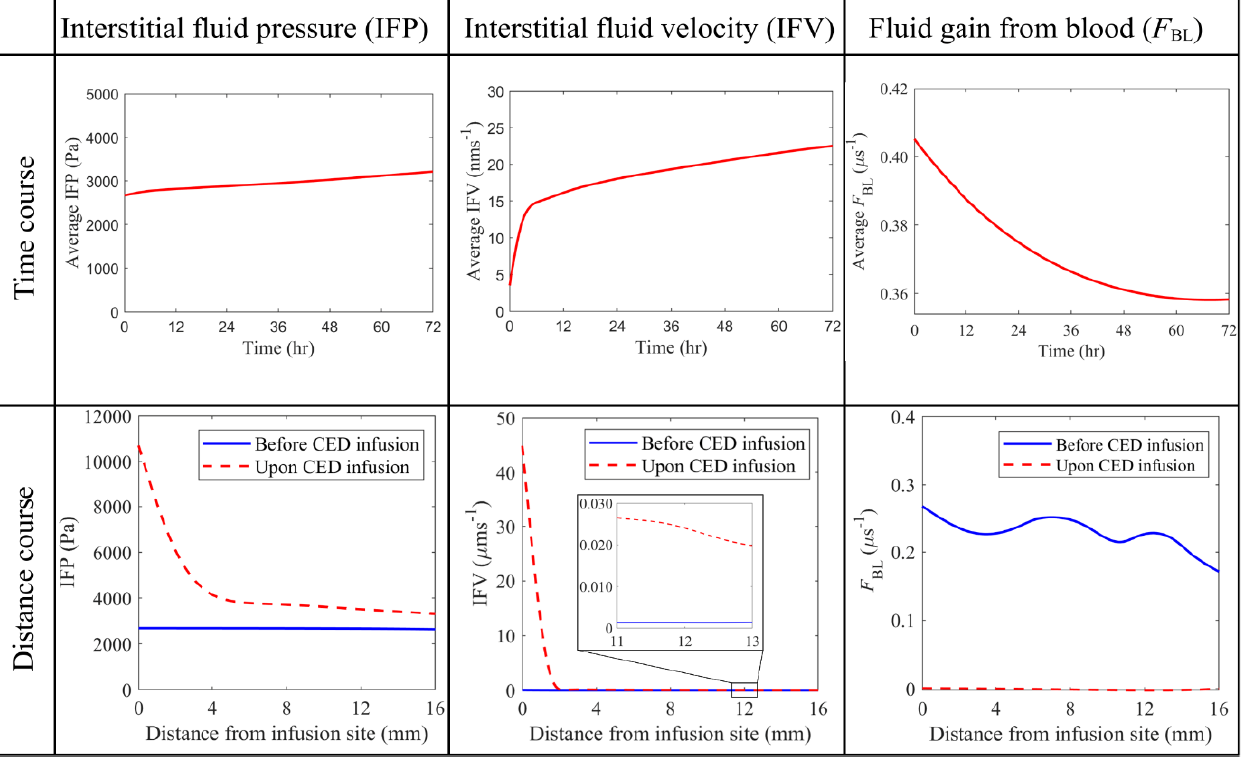
Figure 10. Comparison of hydraulic environments before and upon the combined CED infusion. The time course graphs in the top row are plotted using the average values in the entire brain tumor. The results taken on Day 3 are used to plot the distance course graphs in the bottom row.